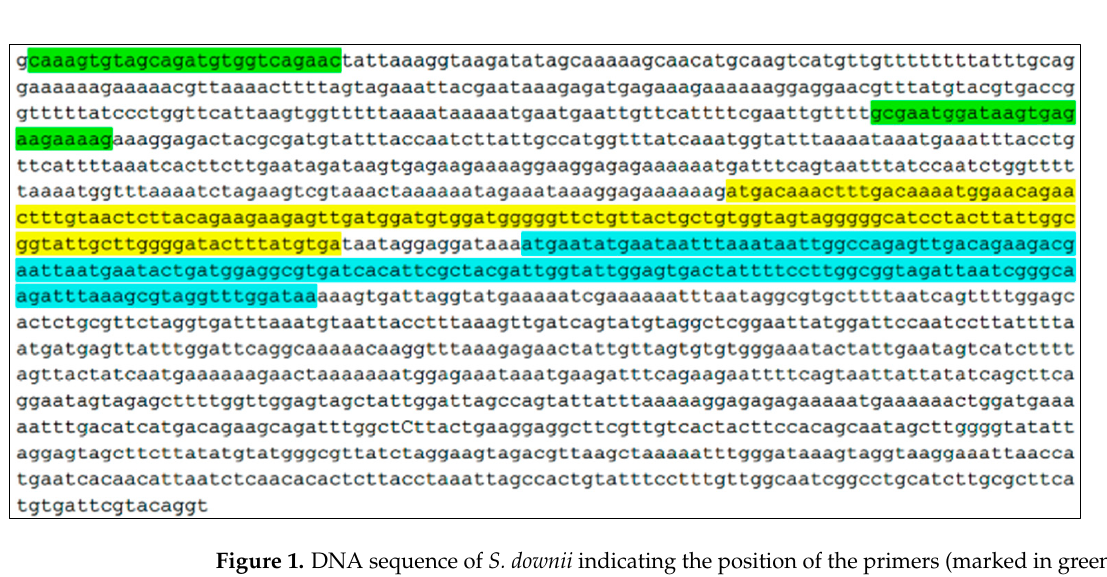
Figure 1. DNA sequence of S. downii indicating the position of the primers (marked in green) and the two open reading frames of the encoded bacteriocins in this fragment (marked in blue and yellow).